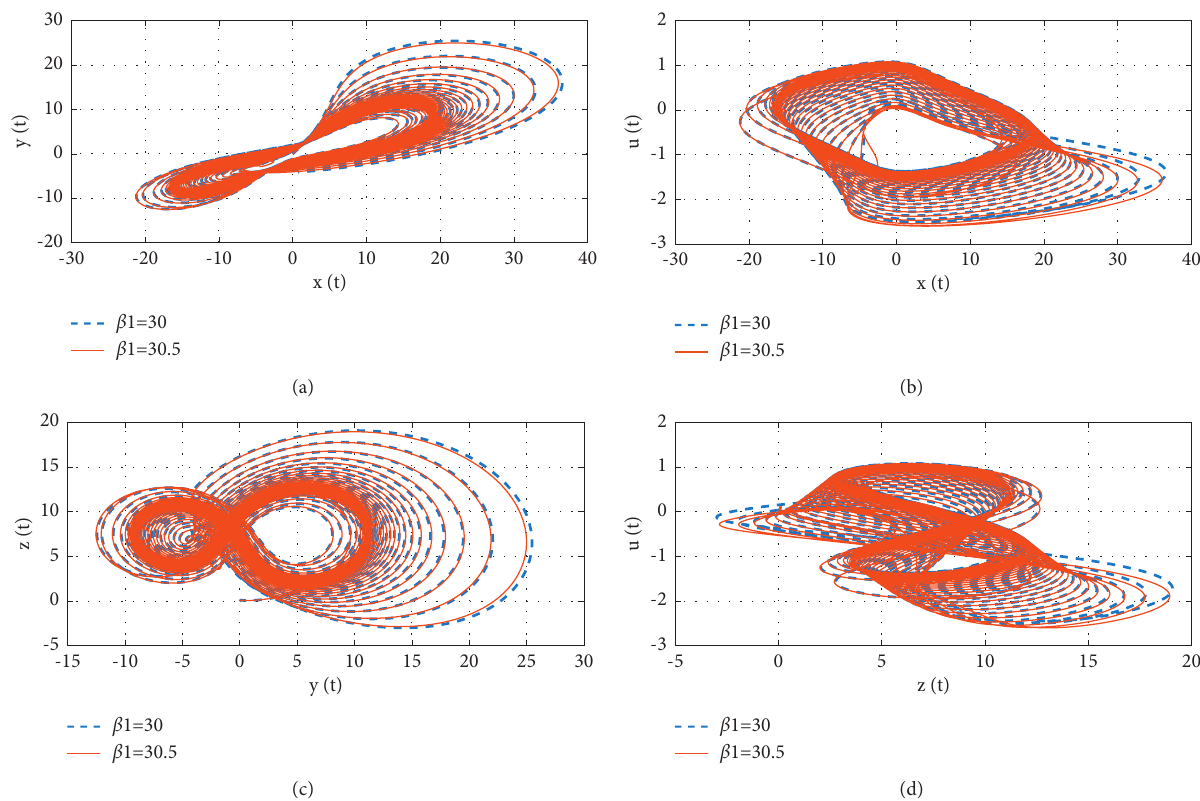
Figure 5: Phase portraits of the system (25) for different values the parameter β